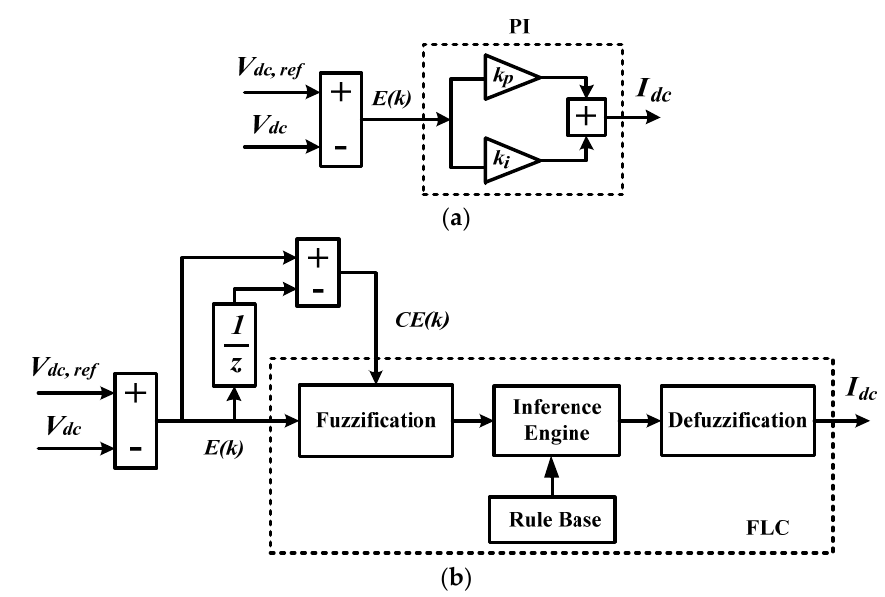
Figure 6. Control structure of direct voltage error manipulation approach with ( a ) PI and ( b ) FLC techniques [38,40].